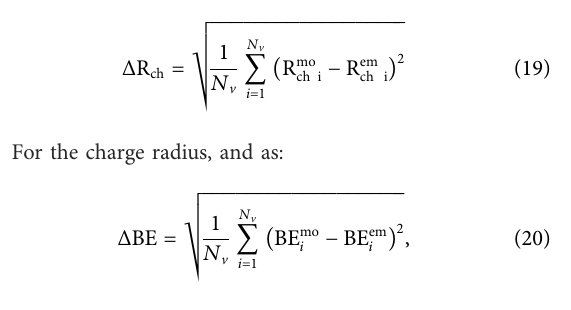
Figure 2): { n g , n f } = {3, 3}. On the next step, we re-calculate